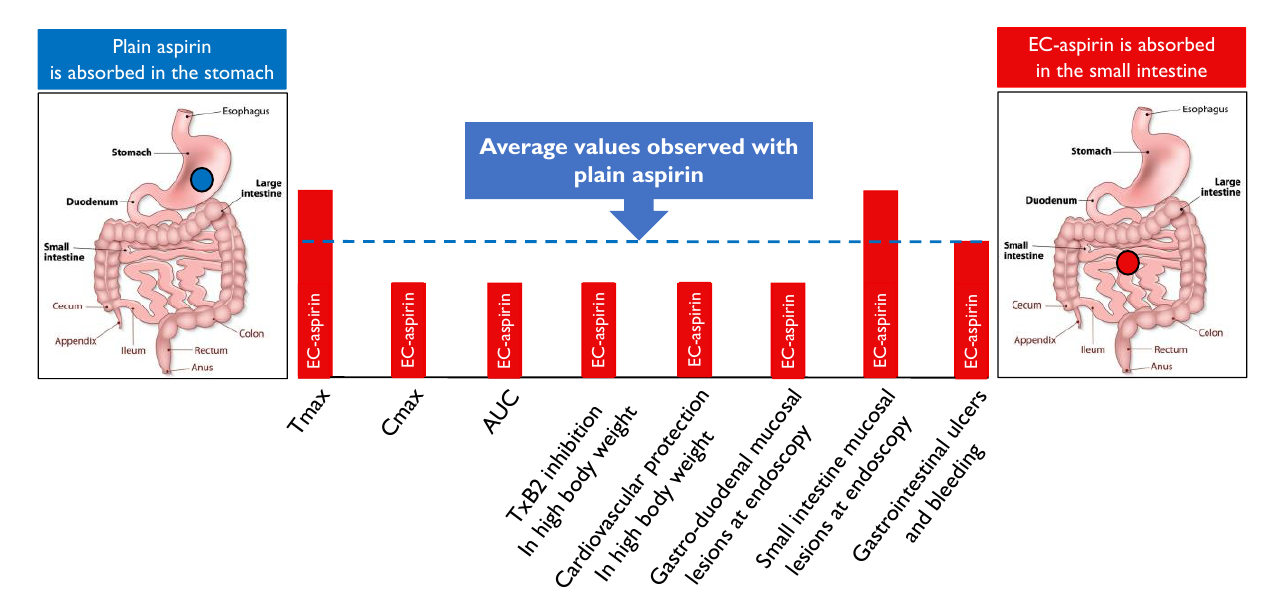
Figure 1. Pharmacological profile, clinical efficacy, and safety of enteric coated (EC) aspirin compared to plain aspirin. The height of the histograms shown in the figure is not reflecting real data and should be interpreted as illustrative of the average values obtained in several studies with EC-aspirin relative to plain aspirin (higher, equal, lower). Pharmacokinetic parameters (usually measured in serum): Tmax = time to peak drug concentration; Cmax = peak drug concentration; AUC = Area Under the Curve (integral of drug concentration as a function of time). TxB2 = thromboxane B2 (a stable metabolite of thromboxane A2).